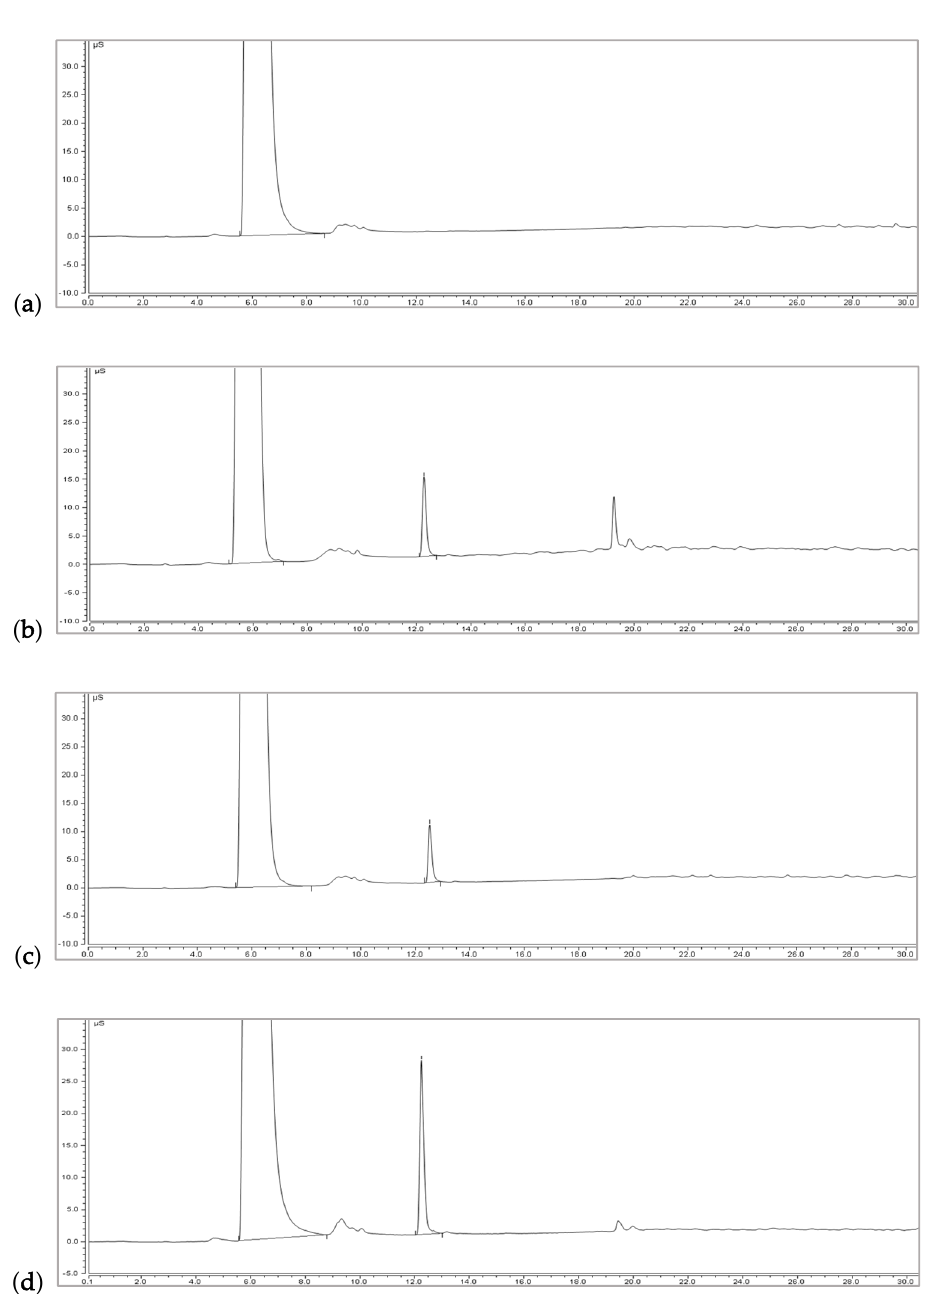
Figure 5. IC analysis of collected processed food samples: ( a ) negative sample; ( b ) positive sample labeled with DCP; ( c ) positive sample labeled with TCP; ( d ) positive sample labeled with a mix of DCP with